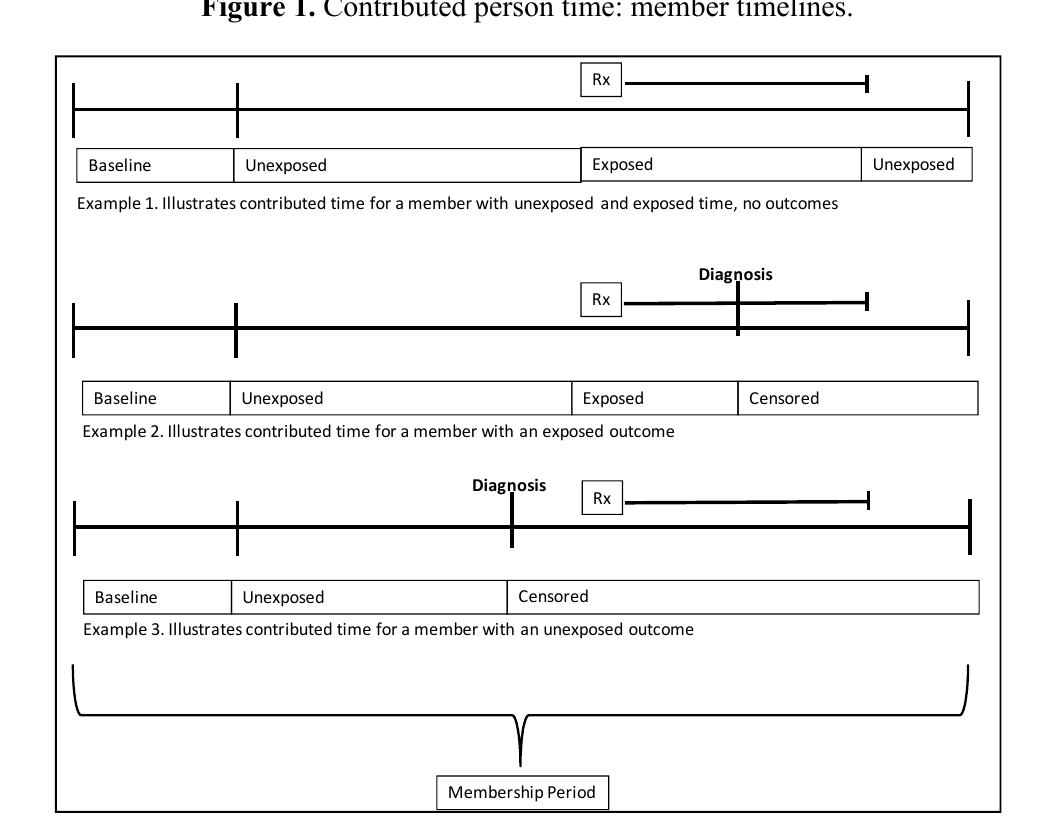
Figure 1. Contributed person time: member